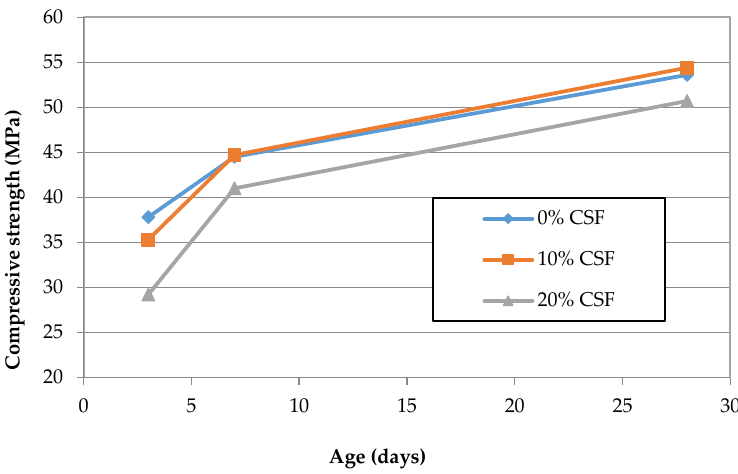
Figure 15. Compressive strength development of mortars.